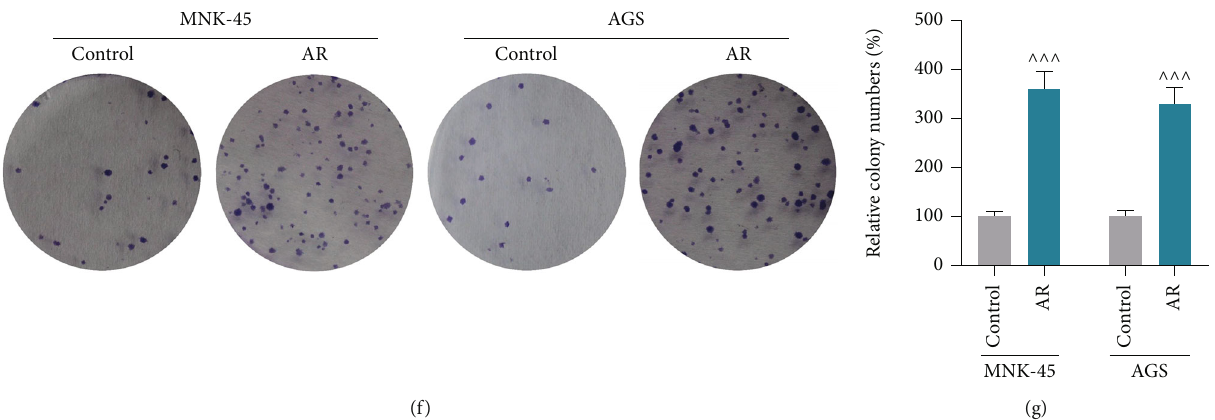
Figure 1: Gastric cancer cells have stronger anoikis resistance compared with normal gastric mucosa epithelial cells. (a) Numbers of GES-1 , MNK-45 and AGS cells were counted by a hemacytometer after suspension culture for 0, 2, 4, and 6 days. (b) Apoptosis rates of GES-1 , MNK- 45 and AGS cells after 24-hour adherent culture or suspension culture were quantitated through cell apoptosis assay. (c) Cell apoptosis was evaluated using a fl ow cytometer and an Annexin-V-FITC Apoptosis Detection Kit with PI. (d) Pictures of the morphology of GES-1 , MNK- 45 and AGS cells in suspension culture were taken under a microscope. (e) Numbers of aggregated GES-1 , MNK-45 and AGS cells in suspension culture were counted by microscopy. (f) Representative pictures of colonies in colony formation assay. (g) Relative cell colony numbers were counted manually. ∗ p < 0.05 vs. GES-1 cells; ∗∗∗ p < 0.001 vs. GES-1 cells and ^^^ p < 0.001 vs. control group. Data were performed as the means ±